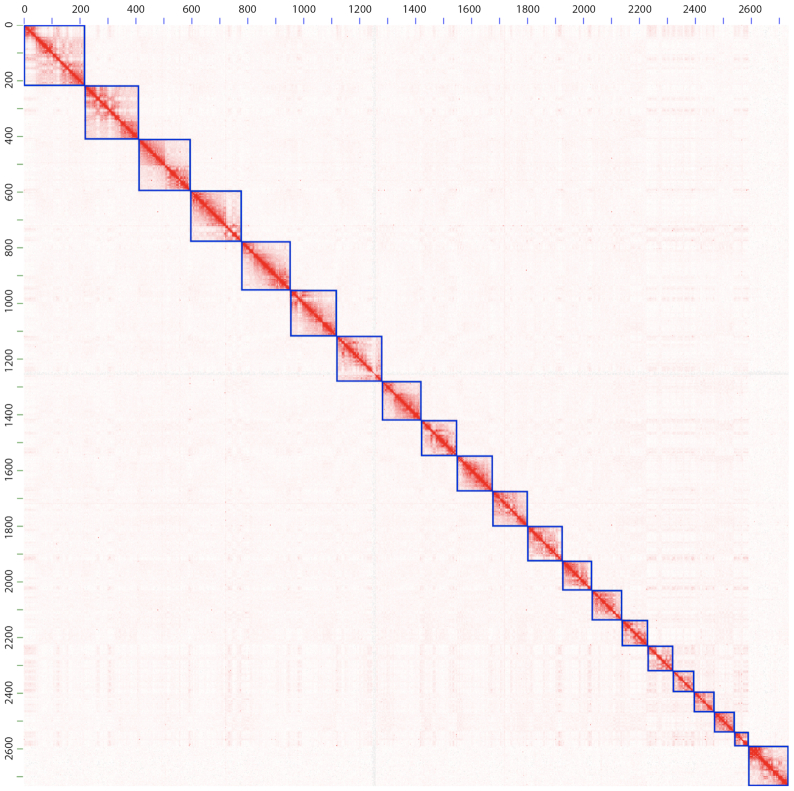
Hi-C map of our Panubis1.0 genome. The figure represents the Hi-C map obtained by aligning Hi-C paired-end reads to the Panubis1.0 genome assembly laid out on the X-axis as well as the Y-axis. Because each read-pair consists of 2 reads, a position (i, j) on this map represents the number of read-pairs where one read aligned to position i and the other read aligned to position j on the Panubis1.0 genome. The intensity of each pixel in this Hi-C map represents the number of reads aligning within that bin. The Hi-C map has been drawn at a resolution of 1.25 Mb. Each blue square on the diagonal represents a chromosome-length scaffold. Autosomes are listed first, ordered by size, and the last square corresponds to the X chromosome. The axes are labeled in units of megabases.